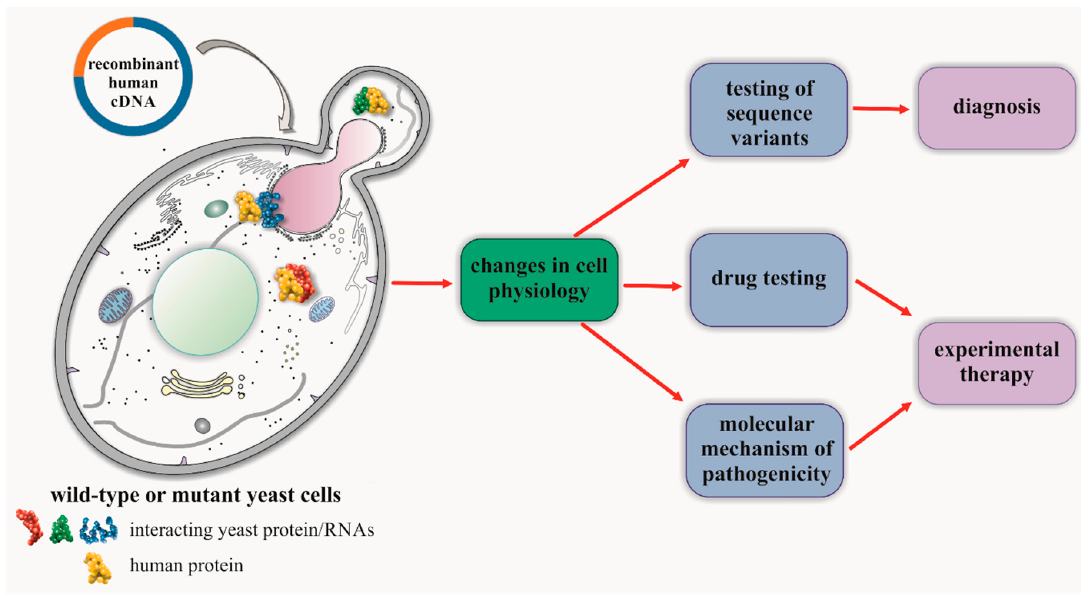
Figure 2. Yeast as a system to evaluate functional effects of human genetic variations. The coding part of a human gene (cDNA) is inserted under a yeast regulatory sequence and transformed into yeast cells, where it is expressed. The resulting protein interacts with yeast cellular components (proteins, RNAs, lipids, etc.) and affects the cell physiology, leading to the selected phenotypes which may be monitored. The system presented may be used to test unknown sequence variants to improve diagnosis, or for screening drug candidates and investigating the molecular mechanisms of pathogenicity to develop future experimental therapies.